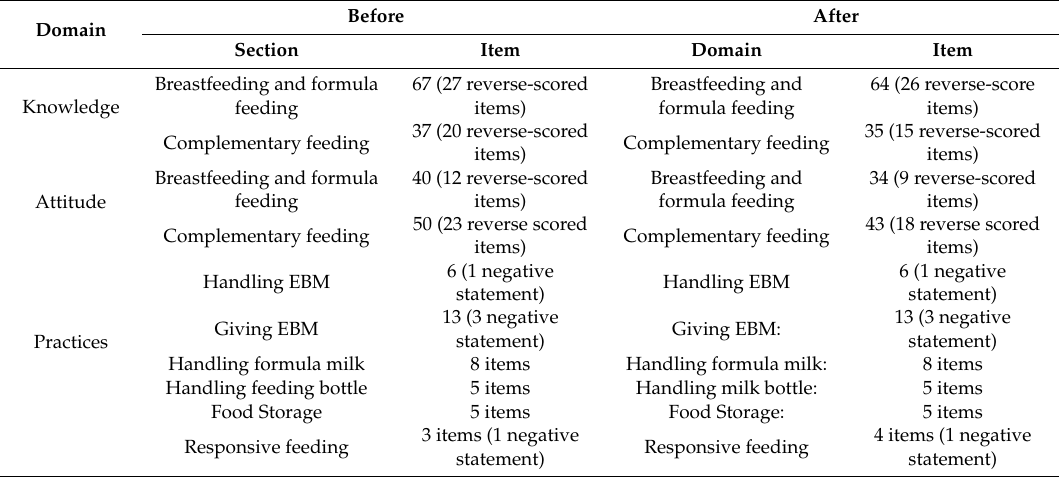
Table 8. Summary of items in IYCF-CCPQ before and after psychometric